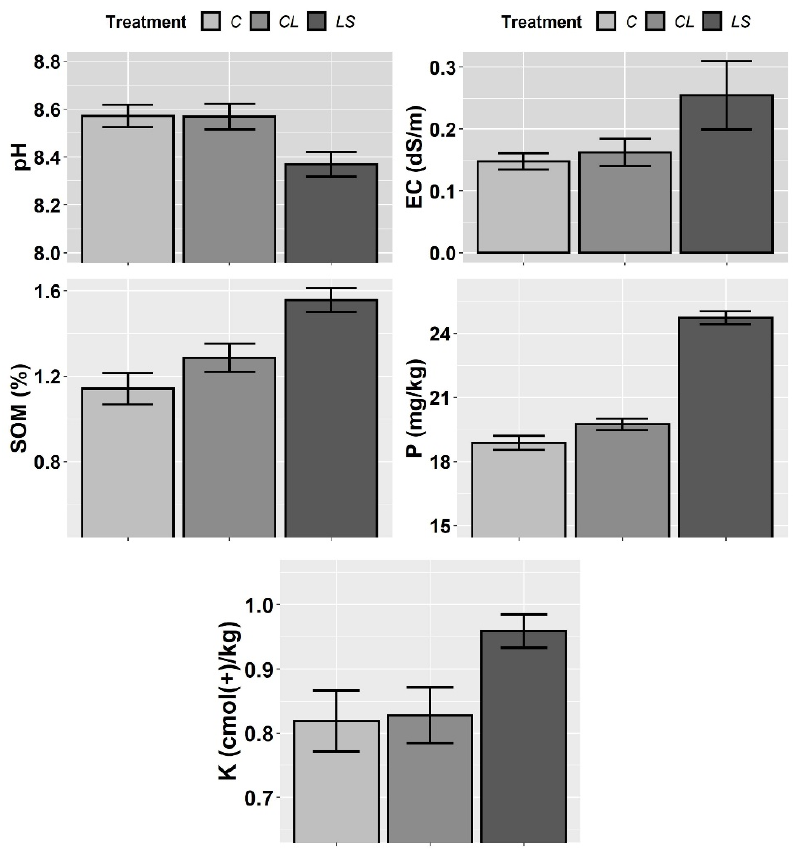
Figure 1. Mean values of the soil parameters pH, electrical conductivity (EC), soil organic matter (SOM), phosphorus (P) and potassium (K) for each treatment. Treatments: control (C), control of leonardite (CL), and leonardite mixed with ferrous sulphate heptahydrate (LS). Error bars reflect the SE of the mean (±1 SE mean).